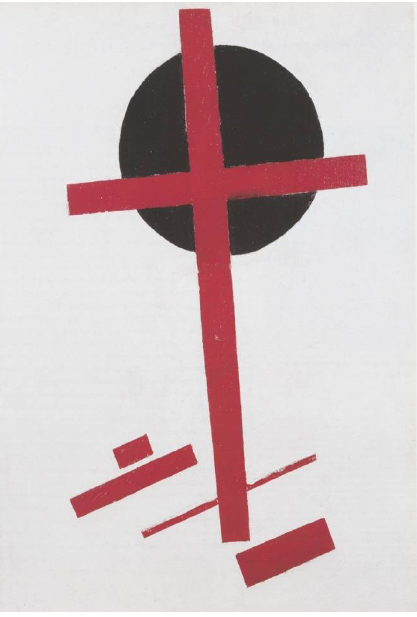
Figure 2. Mystic Suprematism (Red Cross on Black Circle) , 1920–1922. The collection of the Stedelijk Museum of Amsterdam. © Stedelijk Museum.